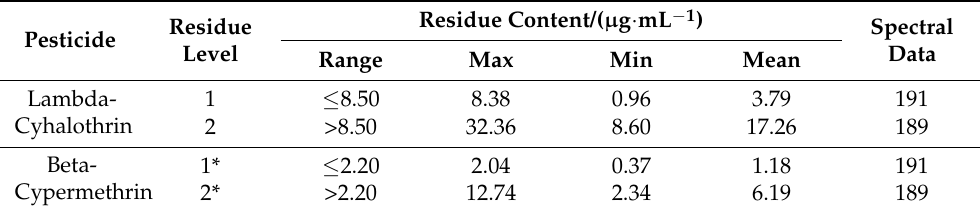
Table 3. Spectral data distribution in two-level discrimination of pesticide residues.